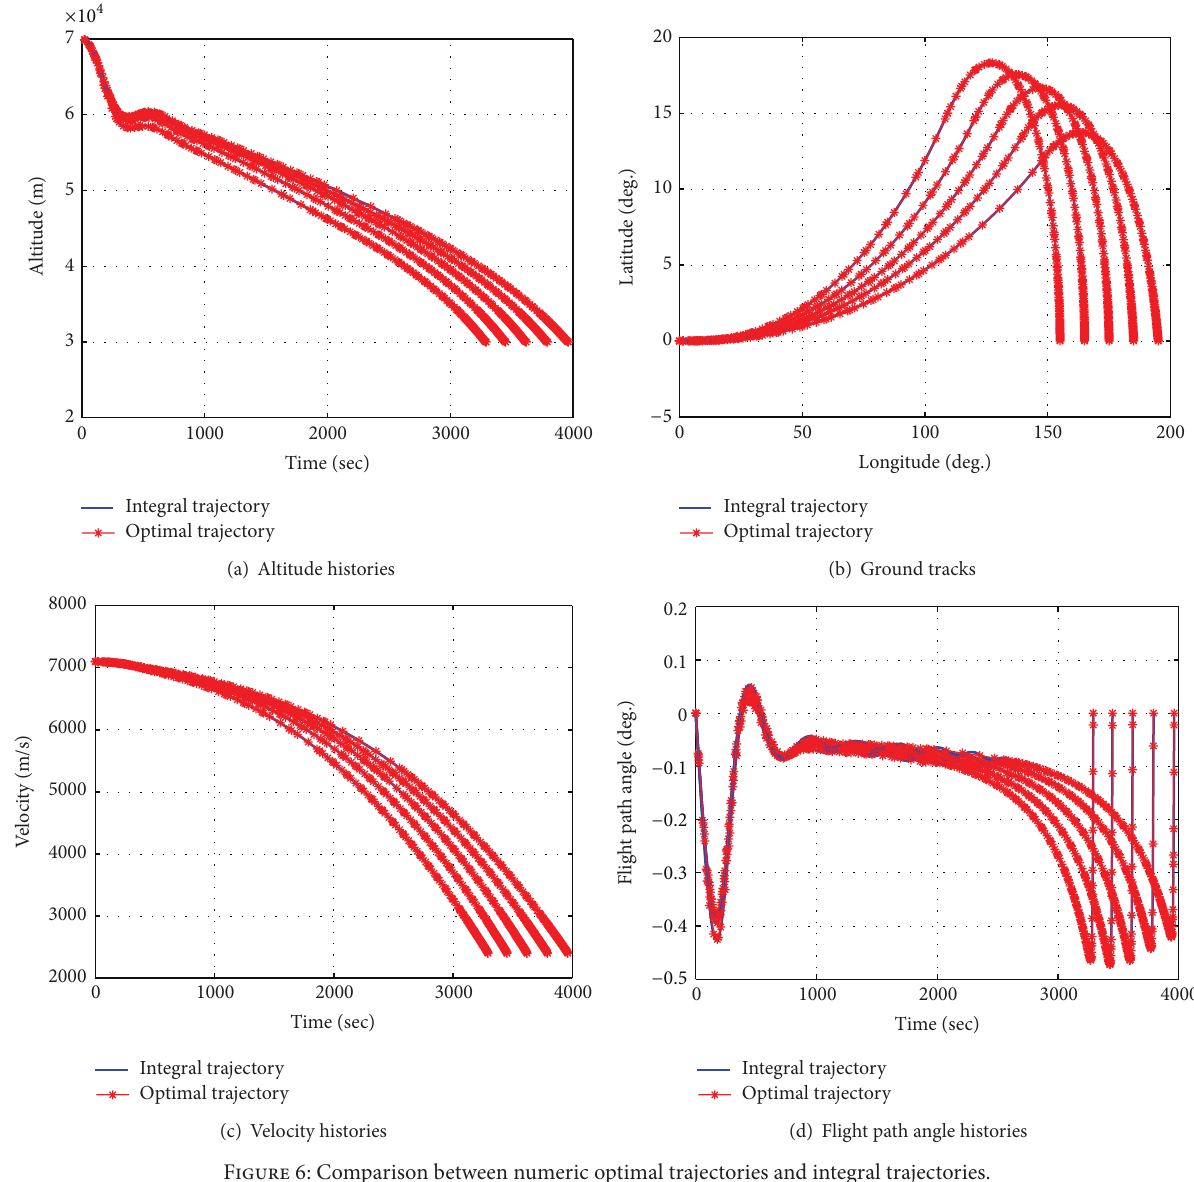
Figure 6: Comparison between numeric optimal trajectories and integral